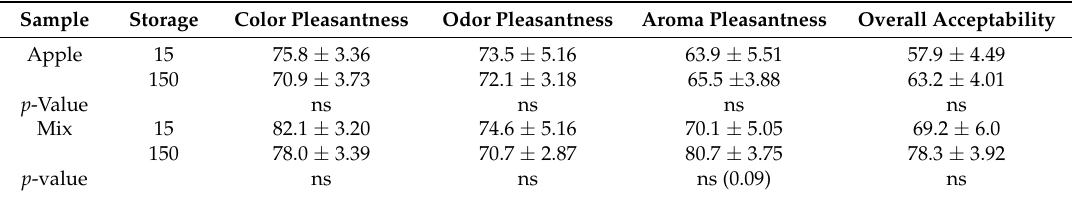
Table 5. Pleasantness of color, odor, aroma, and overall acceptability for the apple-RCW and mix-RCW drinks after 15 and 150 days of storage.